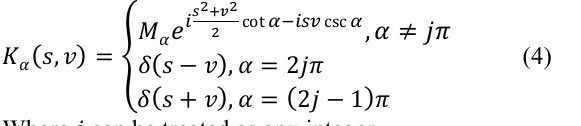
Figure 1. The structure of MLP